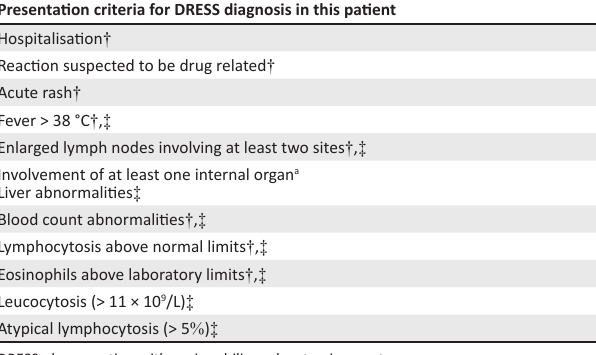
TABLE 2: Clinical and laboratory presentation criteria. Presentation criteria for DRESS diagnosis in this